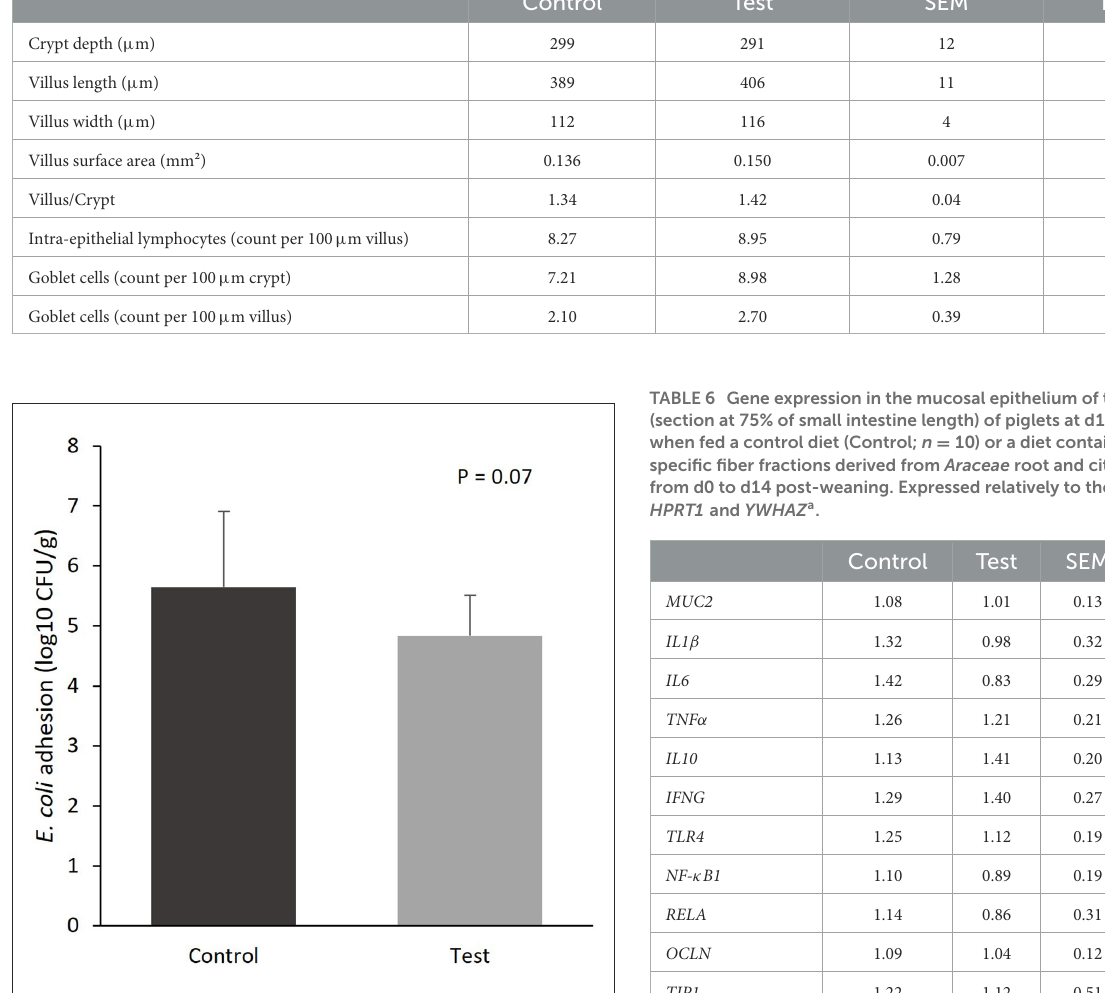
FIGURE1 E. coli colonization of the mucosal epithelium of the small intestine (section at 75% of small intestine length) of piglets at d14 post-weaning, when fed a control diet (Control; n = 10) or a diet containing 2 kg/ton specific fiber fractions derived from Araceae root and citrus (Test; n = 10) from d0 to d14 post-weaning.